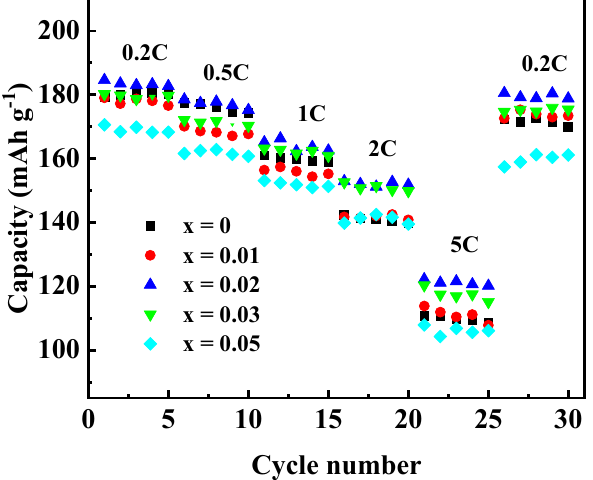
Figure 8. Rate capabilities of Li[Ni 0.6 Co 0.2 Mn 0.2 ] 1-x Ga x O 2 .